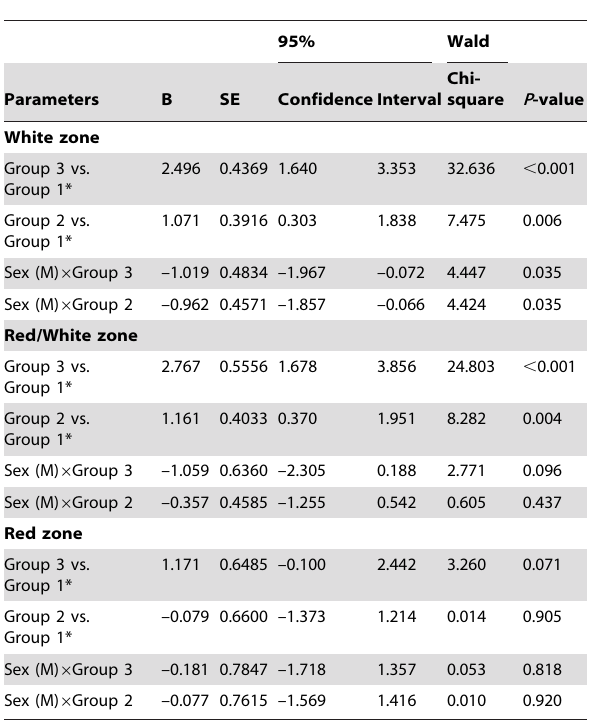
Table 6. Comparisons of zonal T2 values among three age groups and two gender groups after adjusting for the BMI effect in multiple linear regression analysis with